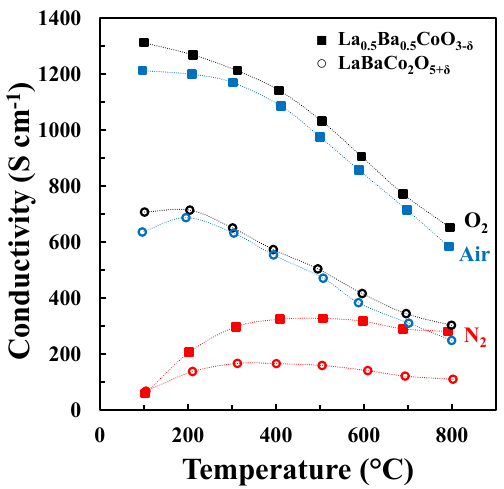
Figure 7. Four ‐ point DC conductivity as a function of temperature for La 0.5 Ba 0.5 CoO 3 ‐δ (closed squares) and LaBaCo 2 O 5+ δ (open circles) in O 2 (black), air (blue) and N 2 (red). The dotted lines are guides to the eye.